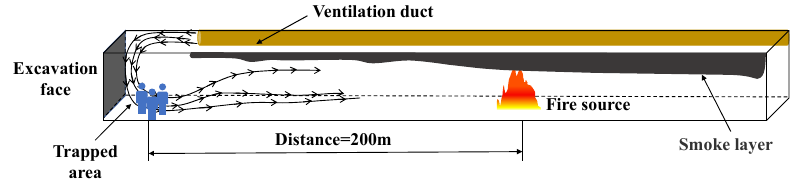
Figure 1. Schematic diagram of the fire accident at Liangbaosi.